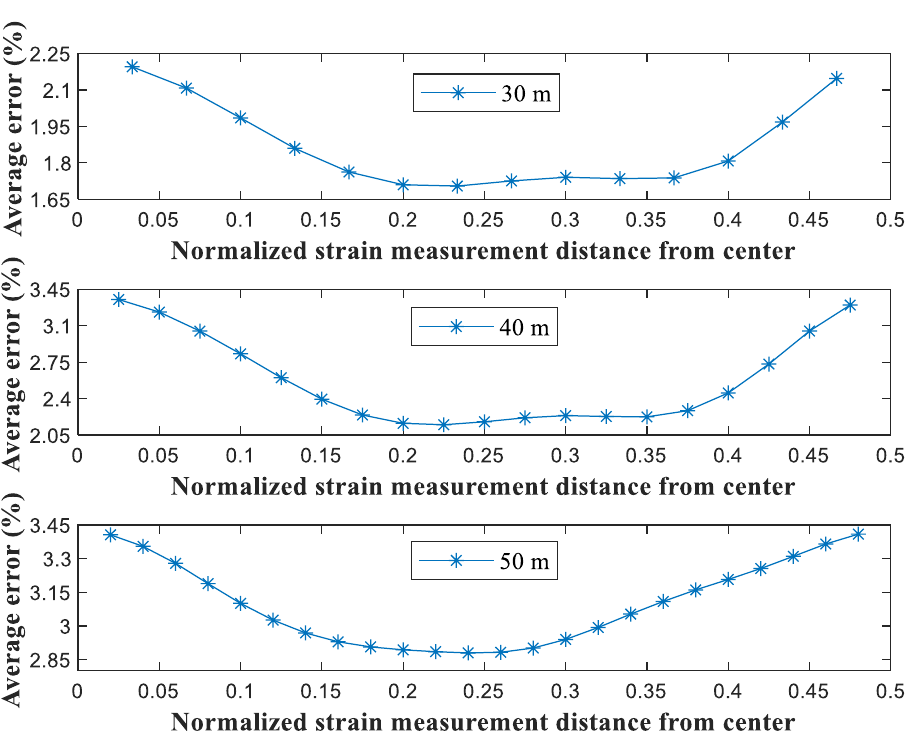
Figure 6. RMSE error dependence on the normalized distance from the center of the bridge.